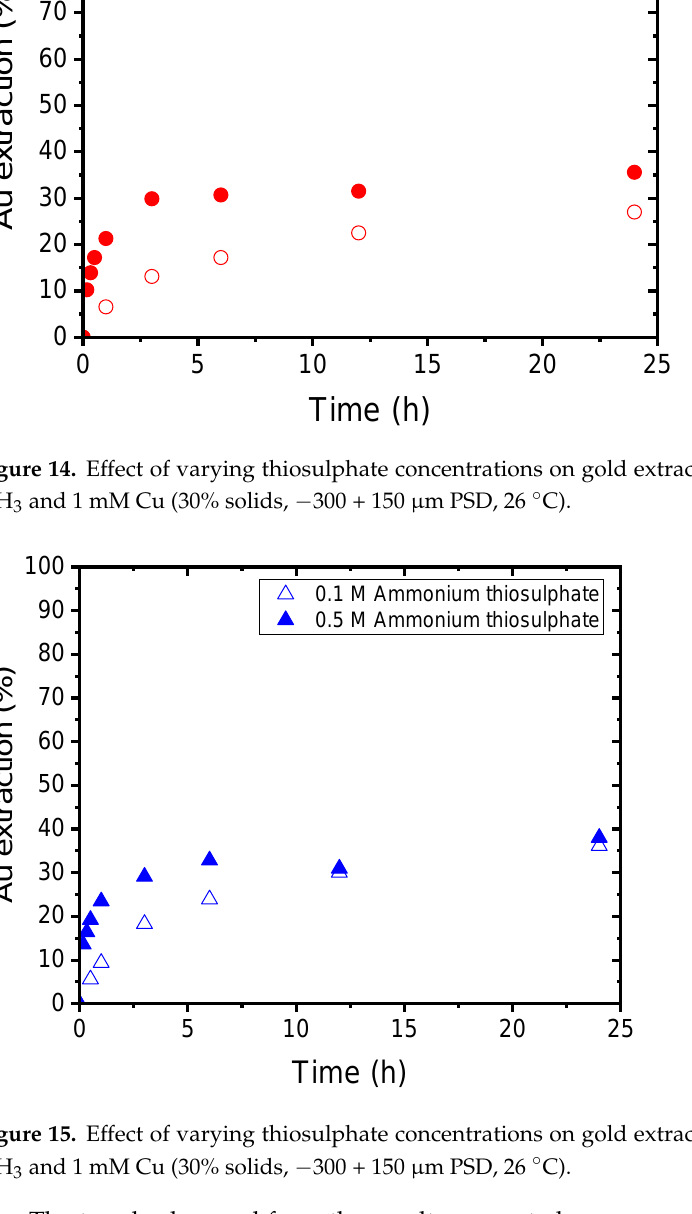
Figure 15. Effect of varying thiosulphate concentrations on gold extraction for Sample 3 at 0.5 M NH 3 and 1 mM Cu (30% solids, −300 + 150 µm PSD, 26 °C).